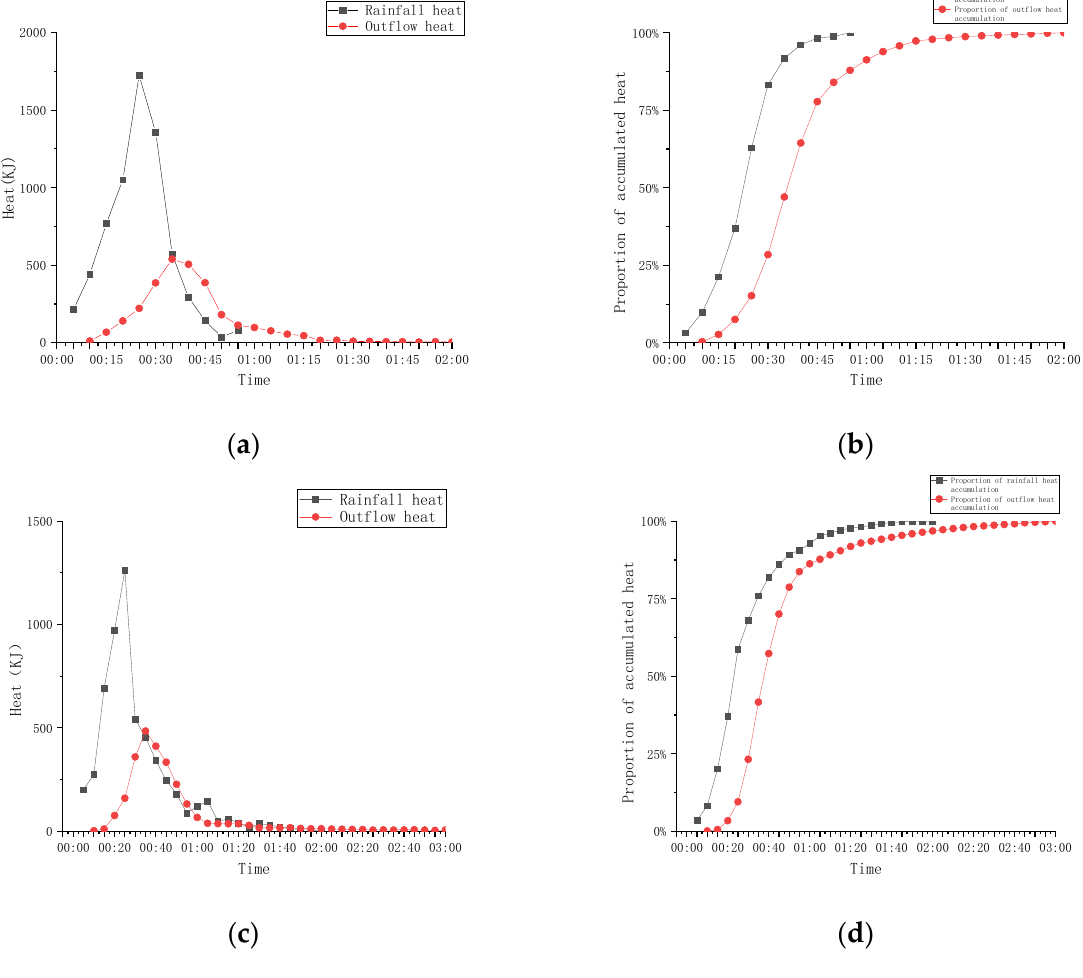
Figure 7. Experimental results of rainfall and outlet heat: ( a ) rainfall and outflow heat curve under 60 min rainfall duration; ( b ) rainfall and outflow heat accumulation curve under 60 min rainfall duration; ( c ) rainfall and outflow heat curve under 120 min rainfall duration; ( d ) rainfall and outflow heat accumulation curve under 120 min rainfall duration.